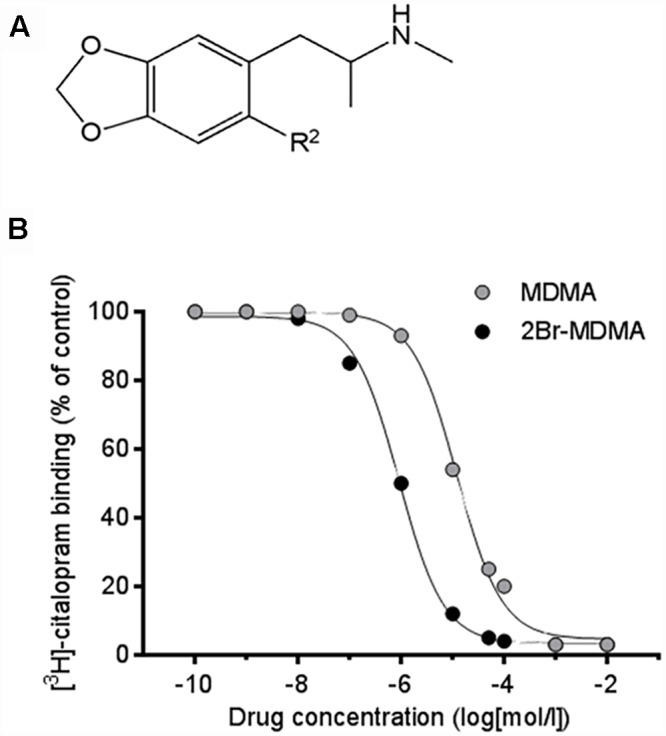
(A) Chemical structures illustrating the MDMA moiety. For MDMA, the substituent located at the R2 aromatic position is a hydrogen atom (R2 = H). For 2-Br-4,5-MDMA, the substituent located at the R2 aromatic position is a bromine atom (R2 = Br). (B) Inhibition of specific [3H]-citalopram binding to human platelet membranes by MDMA and 2-Br-4,5-MDMA, allowing the calculation of inhibition constant (Ki) values (means ± SEM) from three separate experiments. For MDMA, Ki = 9880 ± 1231 nM; for 2-Br-4,5-MDMA, Ki = 1060 ± 50.2 nM (p < 0.002, two-tailed unpaired Student’s t-test). Reference values of Ki for serotonin and citalopram were 870 and 0.42 nM, respectively (curves not shown).